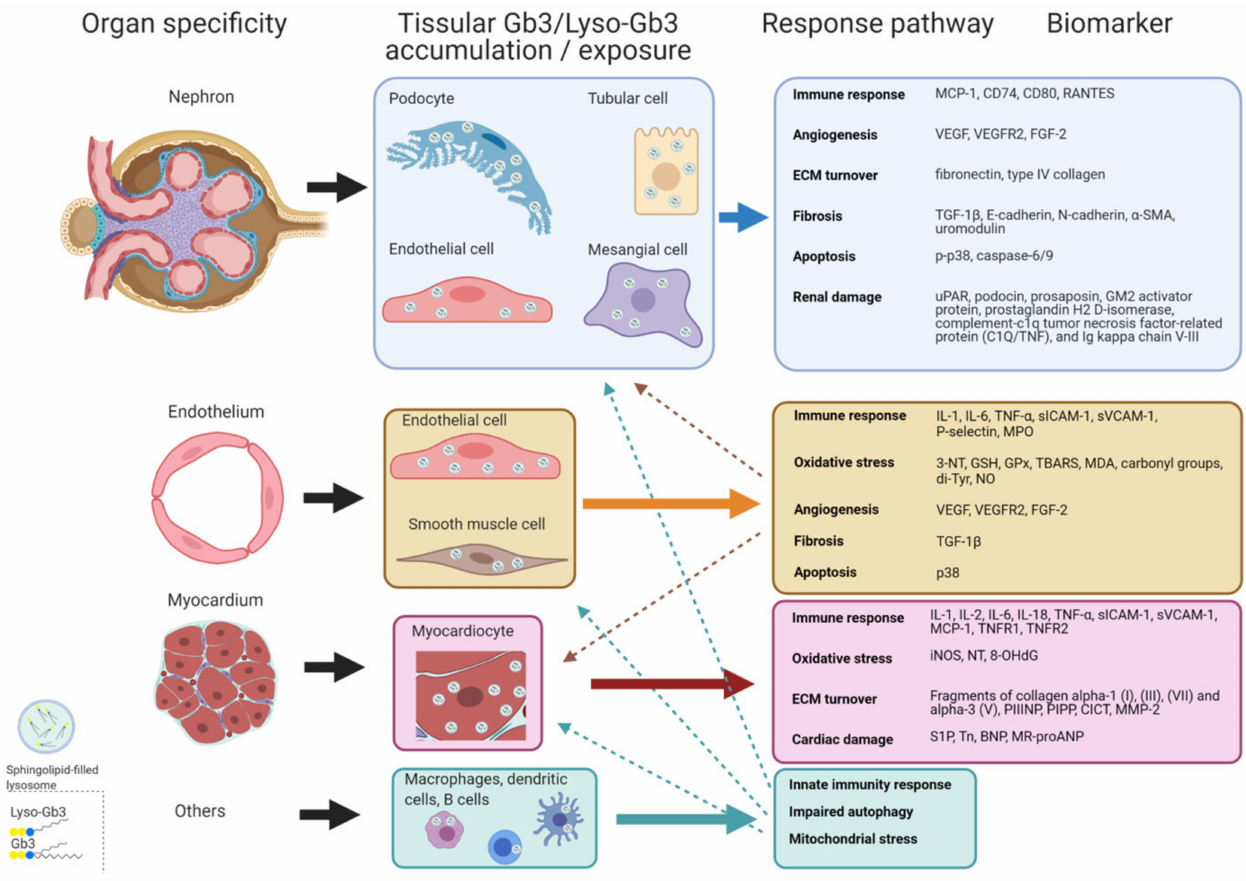
Figure 2. Scheme of potential pathogenic response pathways. Response pathways promoted from Gb3 and/or lyso-Gb3 accumulation and/or exposure that can develop in Fabry disease grouped by organ/tissue specificity, with some biomarkers involved. Dashed arrows indicate associations between systemic vasculopathy and renal and cardiac involvement. α -SMA: α -smooth muscle actin; BNP: brain natriuretic peptide; CICT: collagen type I carboxy-terminal telopeptide; FGF-2: fibroblast growth factor-2; Gb3: Globotriaosylceramide; GSH: glutathione; GPx: glutathione peroxidase; Tn: high sensitive Troponin; IL: interleukin; iNOS: inducible nitric oxide synthase; lyso-Gb3: Globotriaosylsphingosine; MCP-1: monocyte chemo- attractant protein; MDA: malondialdehyde; MMP-2: matrix metalloproteinase-2; MPO: myeloperoxidase; MR-proANP: midregional pro-atrial natriuretic peptide; NO: nitric oxide; NT: nitrotyrosine; 8-OHdG: 8-hydroxydeoxyguanosine; PIPP: procollagen type I carboxy-terminal propeptide; PIIINP: procollagen type III amino-terminal propeptide; sICAM-1: soluble intercellular adhesion molecule 1; sVCAM-1: soluble vascular cell adhesion molecule 1; S1P: Sphingosine-1- phosphate; TBARS: thiobarbituric acid reactive species; TGF β -1: transforming growth factor beta-1; TNF- α : tumor necrosis factor alpha; TNFR: tumor necrosis factor receptor; Tyr: tyrosine; uPAR: urokinase-type plasminogen activator receptor; VEGF: vascular endothelial growth factor; VEGFR: vascular endothelial growth factor